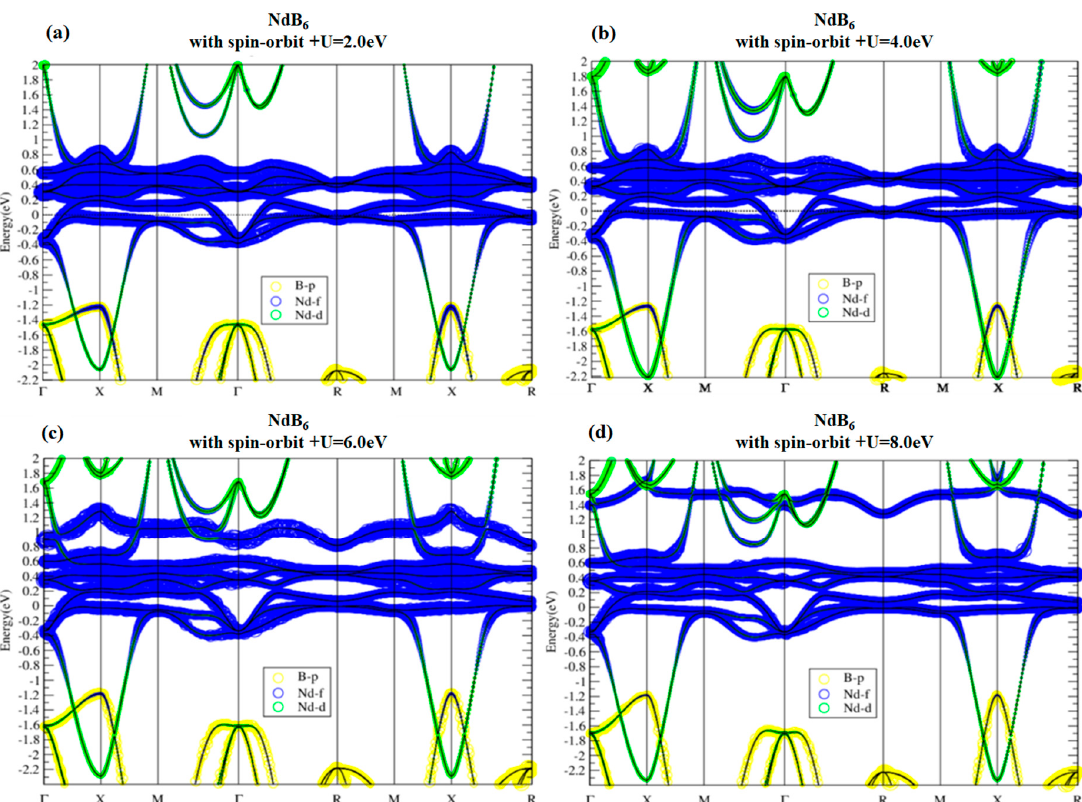
Figure 13. Band structures of NdB 6 with SOI using U = 2, 4, 6, and 8 eV ( a – d , respectively). As U is tuned larger, the highest f band is lifted but the band property is not changed near the Fermi level.